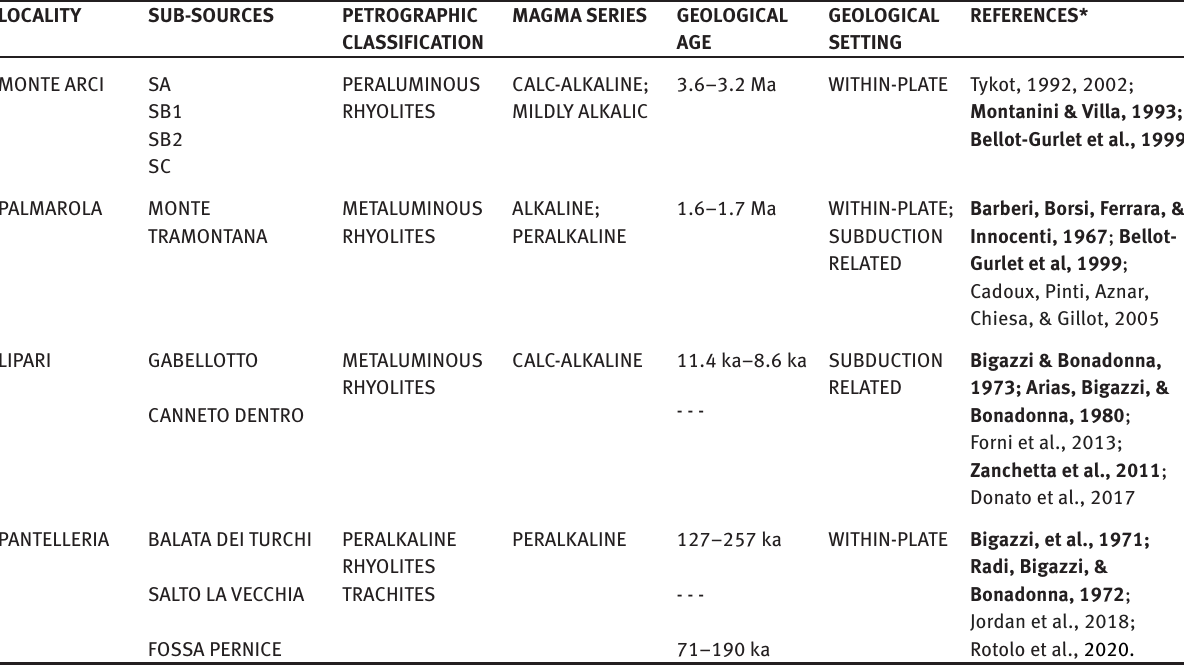
Table 5: Petrographic, geochemical and geological characteristics of the four Central Mediterranean obsidian sources.